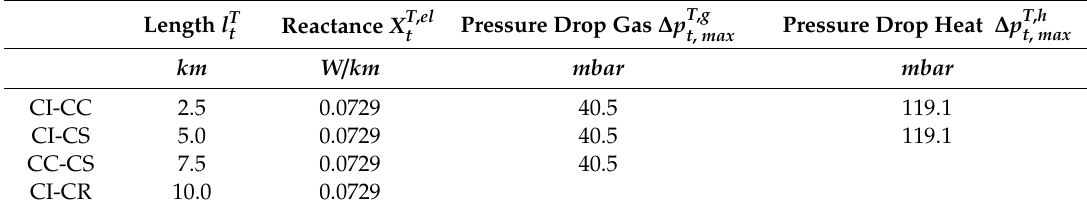
Table 3. Lengths, reactances and pressure drops for the power flow calculations.